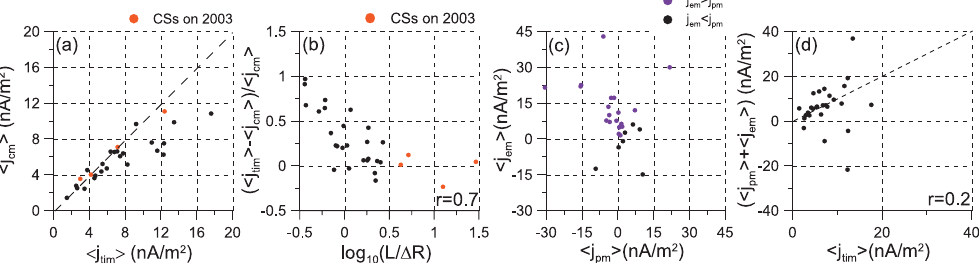
Fig. 4. (a) The comparison of current densities h j cm i and h j tim i determined by curlometer and timing techniques. (b) The correlation between the difference of curlometer h j cm i and timing h j tim i currents and the ratio of the CS thickness L and the average separation between spacecraft 1R . (c) The comparison of proton h j pm i and electron h j em i currents. (d) The comparison between the sum of particle currents